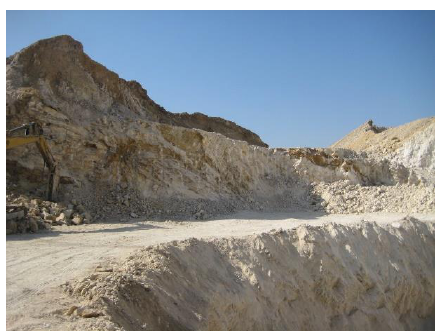
Figure 8b: The core of El Hassana Dome.